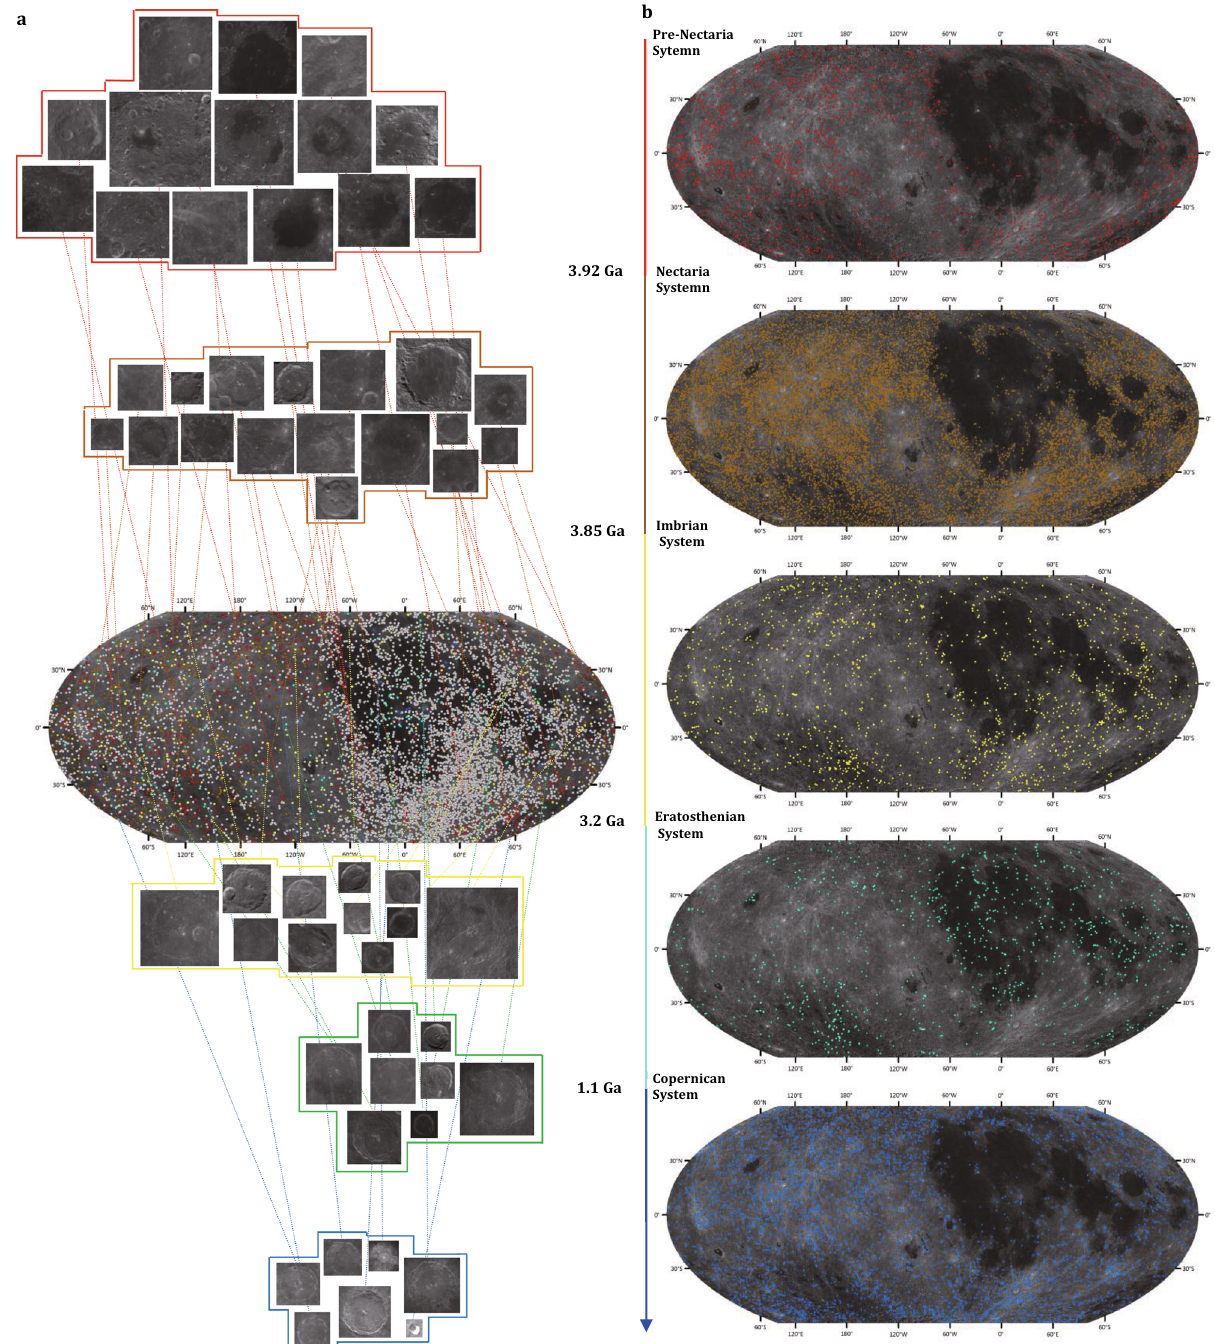
Fig. 1 Distribution of lunar impact craters on the Moon. a The distribution of recognized and dated craters. The red, brown, yellow, green and blue squares and points represent the craters of the pre-Nectarian System, the Nectarian System, the Imbrian System, the Eratosthenian System and the Copernican System, respectively. The grey points show recognized craters without ages. b Distribution of identi fi ed craters with assigned ages. From the time scale and spatial distribution, these dated craters exhibit speci fi c characteristics. Craters with diameters smaller than 8 km and larger than 550 km are not shown in the distribution